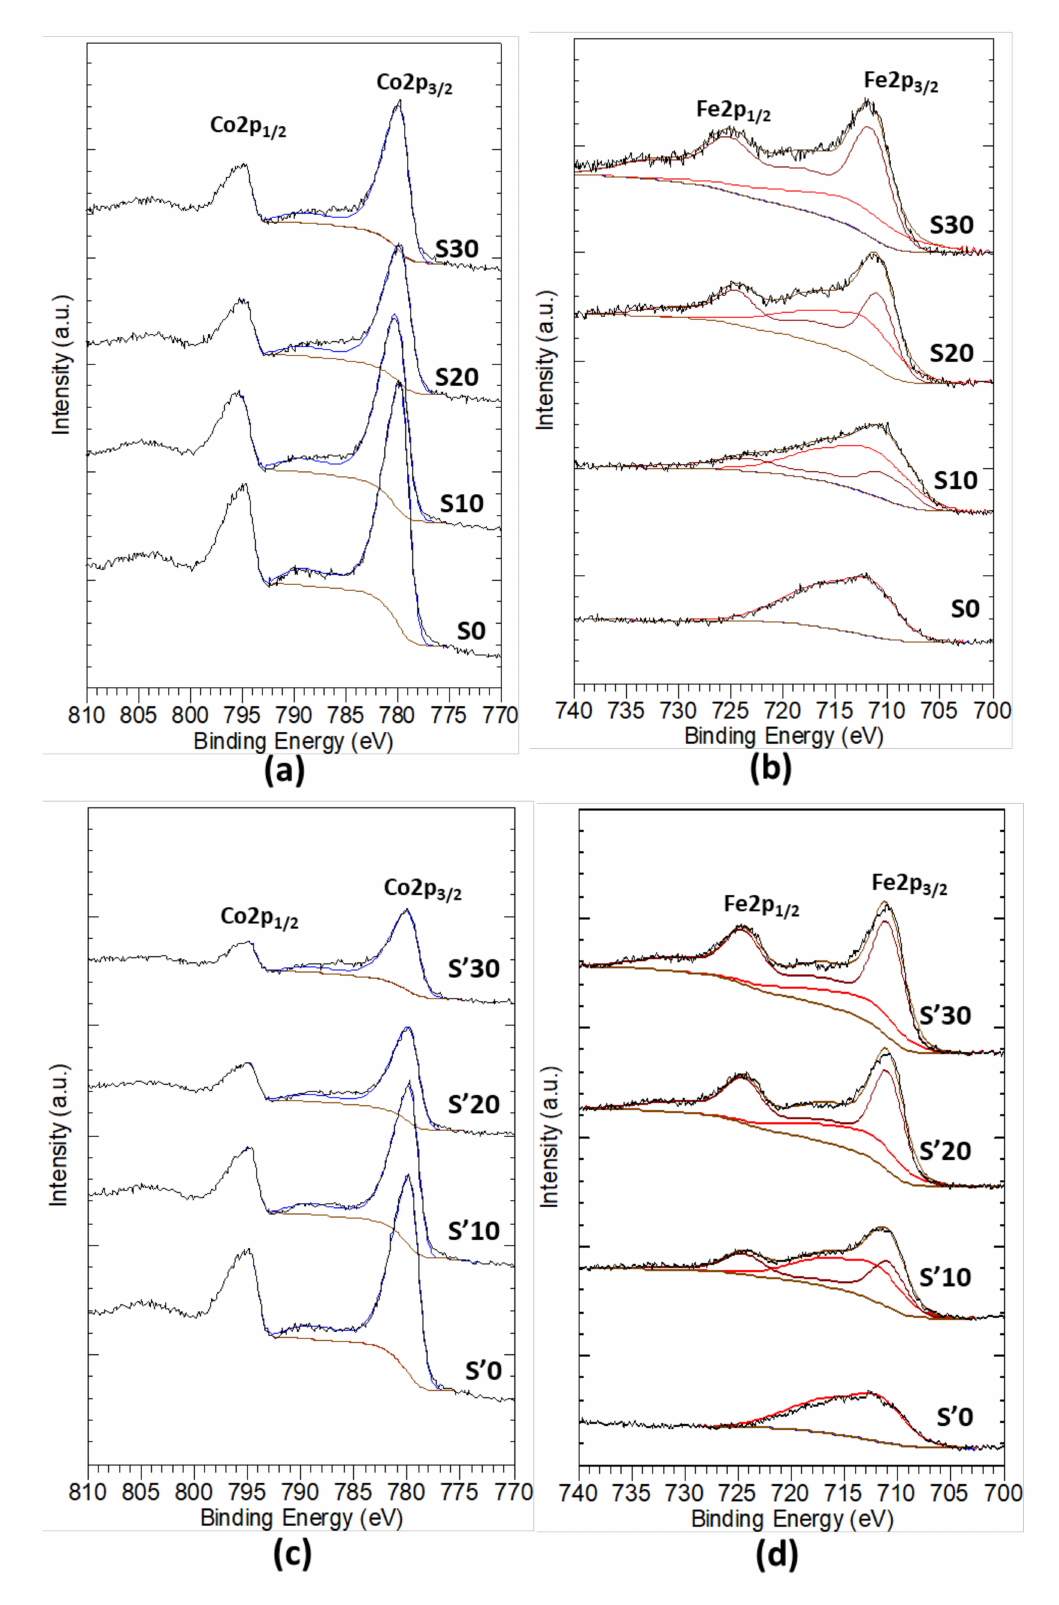
Figure 8. High-resolution X-ray photoelectron spectroscopy (XPS) spectra showing the Co 2p and Fe 2p lines of samples S0, S10, S20, S30 ( a , b ) and S’0, S’10, S’20, S’30 ( c , d